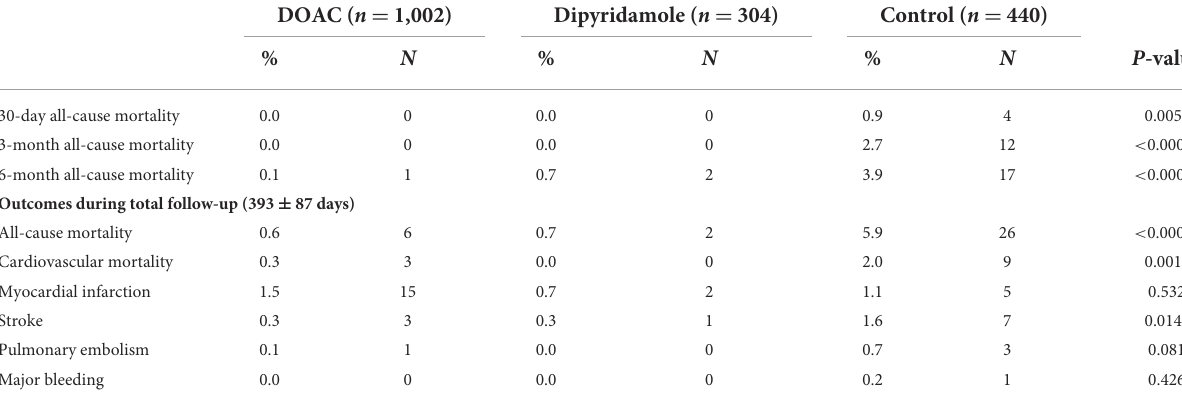
TABLE 2 Outcome of patients enrolled in the three investigated groups.